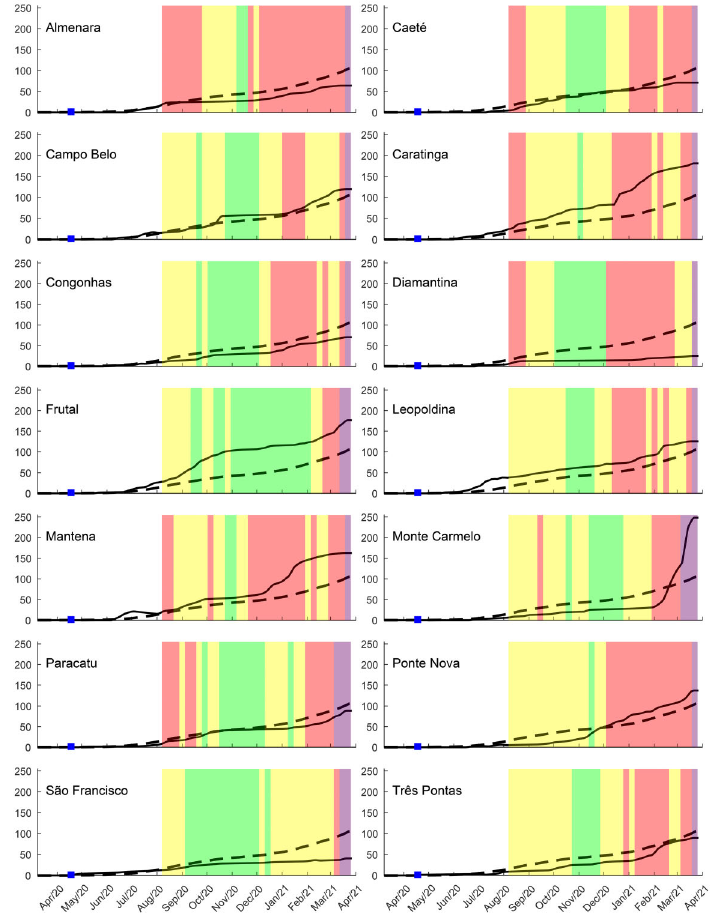
Figure 6. Deaths resulting from COVID-19 (per 100k inhabitants) for the 14 municipalities of Minas Gerais (MG) state macro-regions (full lines) compared with the whole MG state (segmented lines). The colored bands from August 2020 to March 2021 represent the color wave codes de fi ned by the Conscious Minas Plan. The fi rst con fi rmed case within each macro-region is shown as a blue square